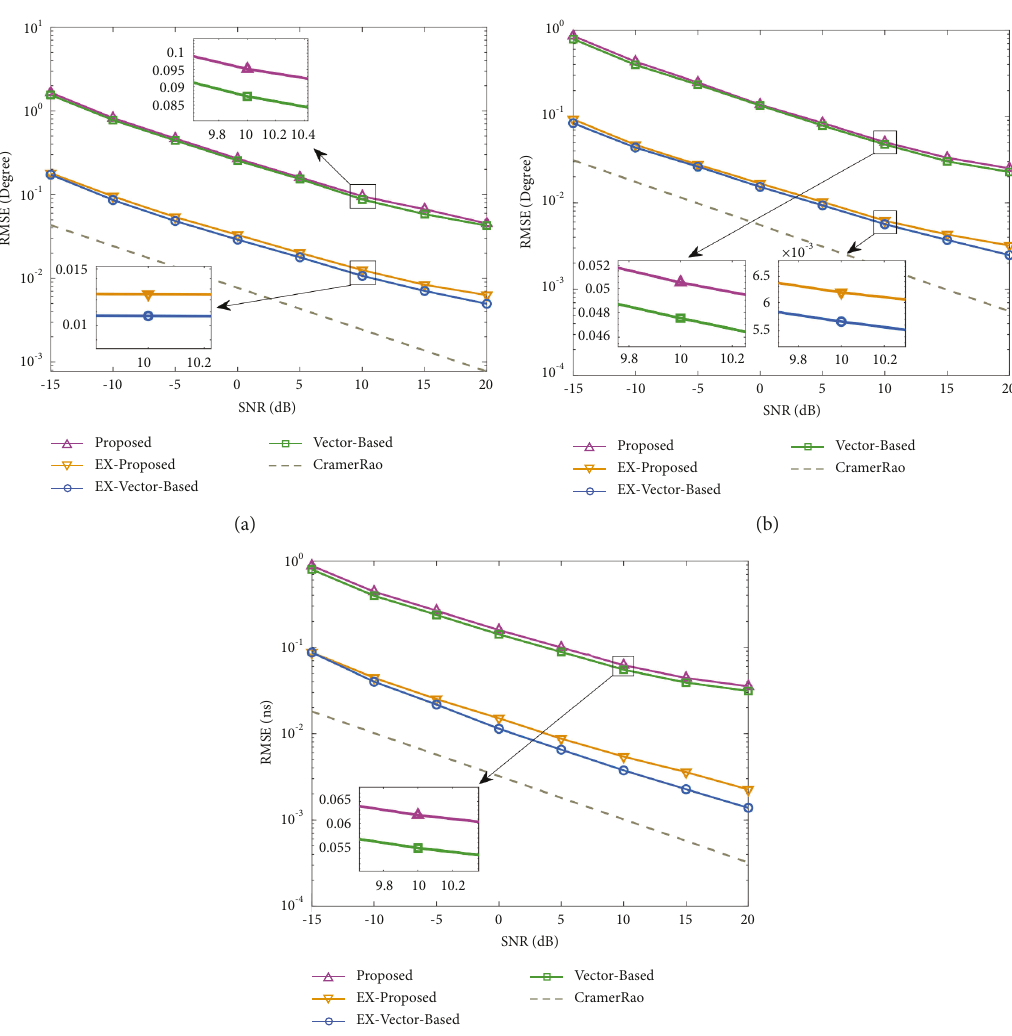
Figure 4: Performance comparison versus SNR: (a) azimuth; (b) elevation; (c) TD.